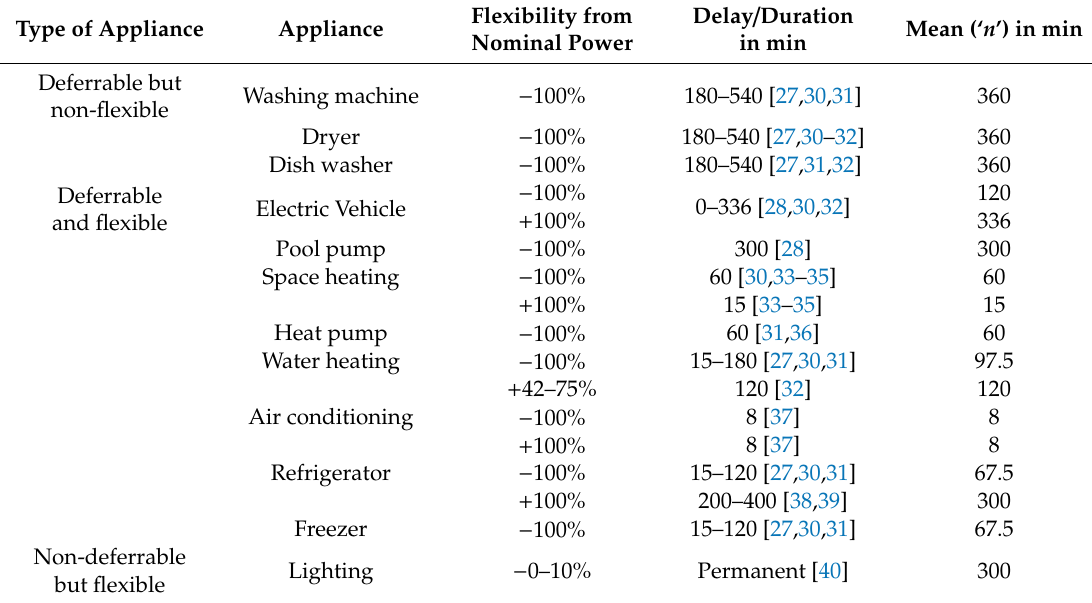
Table 2. Categorisation and flexibility criteria of